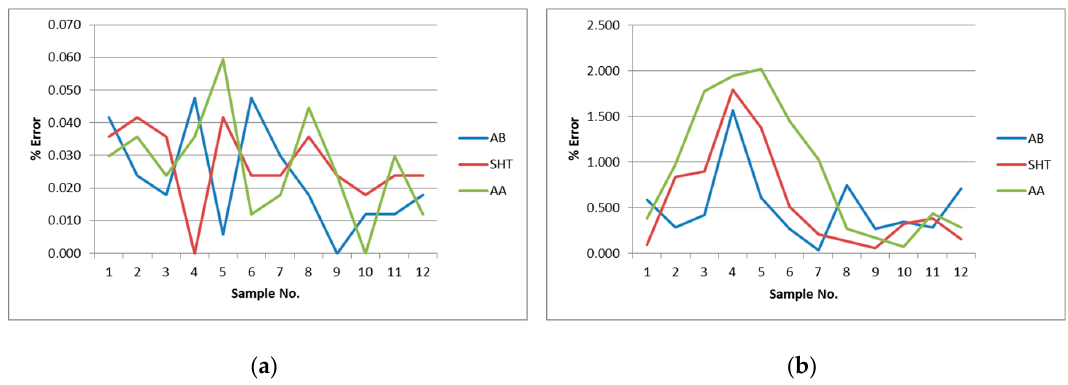
Figure 9. % Error in sample ( a ) length and ( b ) height comparison in As ‐ Built (AB), Solution Heat Treatment (SHT), and Artificial Aging (AA) conditions.